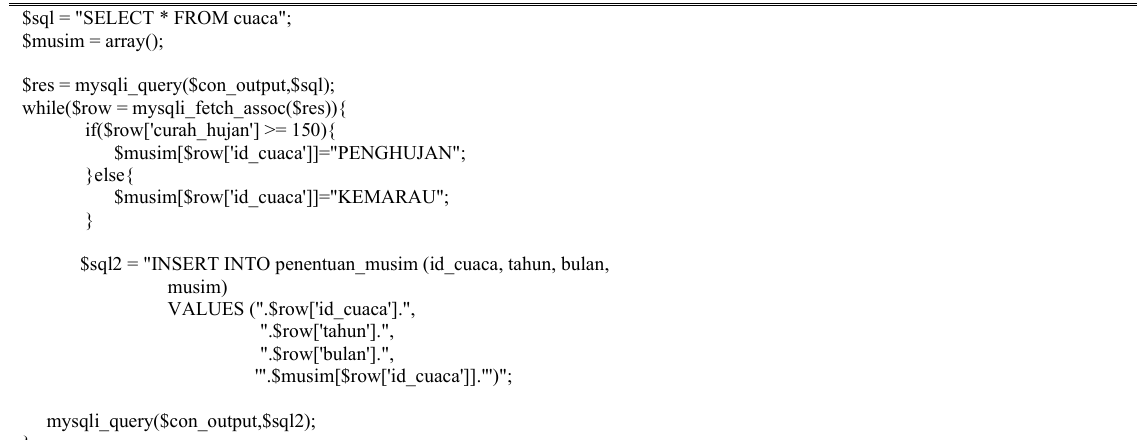
TABLE 10 SOURCE CODE VARIABLE MUSIM